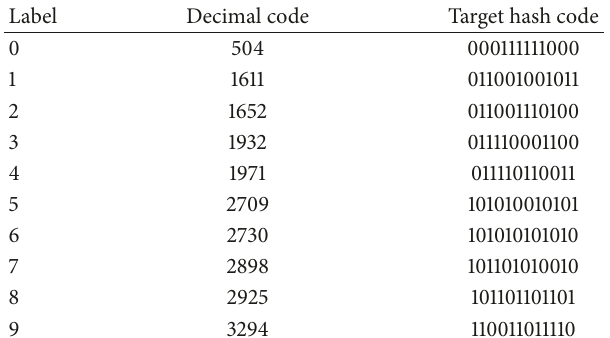
Table 1: Target 12-bit hash code set for a 10-category